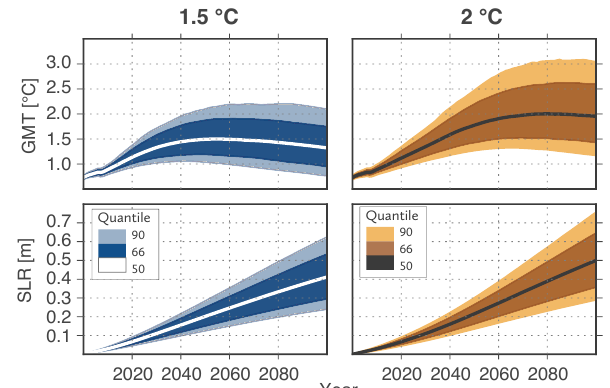
Figure 13. Upper panel: probabilistic GMT projections for illus- trative emission scenarios with a peak warming of 1.5 ◦ C (left pan- els) and 2 ◦ C (right panels) above pre-industrial levels during the 21st century. Lower panels: probabilistic projections of global sea- level rise (SLR) for both scenarios relative to 1986–2005 levels. Un- certainty bands indicate the likely range (66% probability within this range) and the very likely range (90% probability), respec- tively.